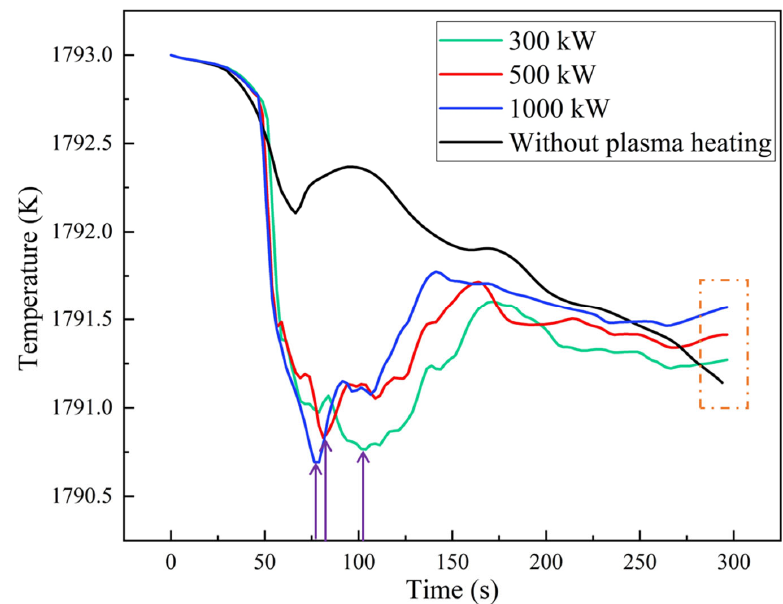
Figure 10. The temperature at outlet 1 with under different heating